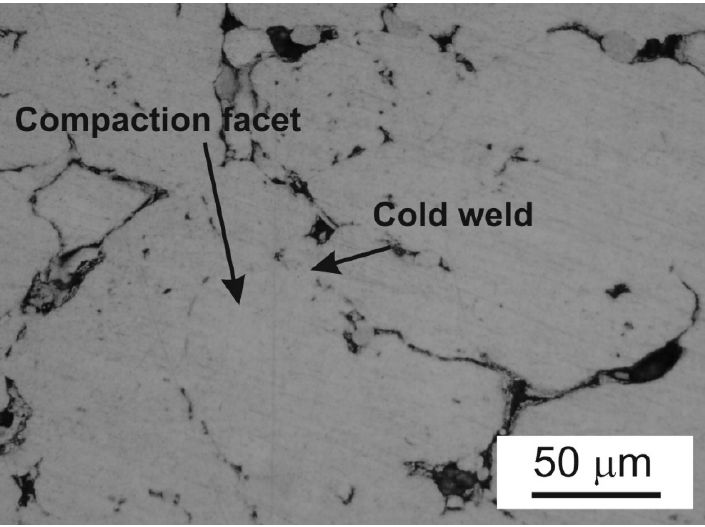
Figure 5. Desirable cold welding in investigated aluminum powder metallurgy (PM) alloy.